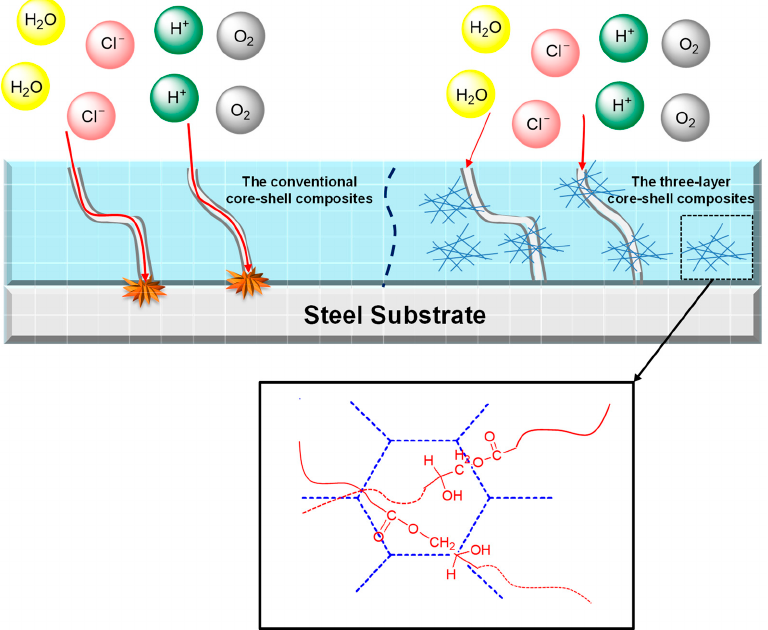
Figure 13. Corrosion protection mechanism of the three ‐ layer core ‐ shell composite latex particles.